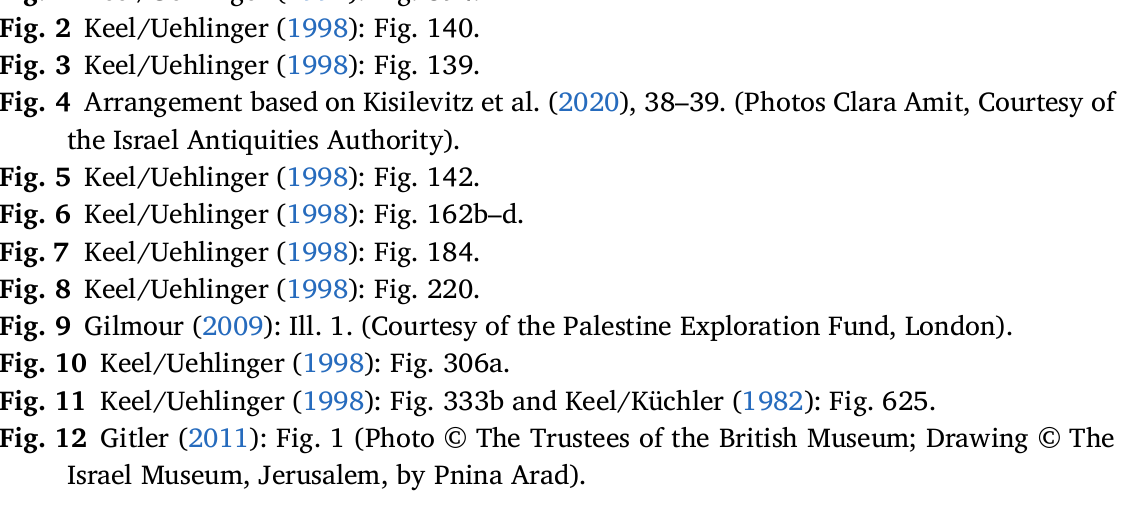
Fig. 1 Keel/Uehlinger (1992): Fig. 394. Fig. 2 Keel/Uehlinger (1998): Fig. 140. Fig. 3 Keel/Uehlinger (1998): Fig. 139. Fig. 4 Arrangement based on Kisilevitz et al. (2020), 38–39. (Photos Clara Amit, Courtesy of the Israel Antiquities Authority). Fig. 5 Keel/Uehlinger (1998): Fig. 142. Fig. 6 Keel/Uehlinger (1998): Fig. 162b–d. Fig. 7 Keel/Uehlinger (1998): Fig. 184. Fig. 8 Keel/Uehlinger (1998): Fig. 220. Fig. 9 Gilmour (2009): Ill. 1. (Courtesy of the Palestine Exploration Fund, London). Fig. 10 Keel/Uehlinger (1998): Fig. 306a. Fig. 11 Keel/Uehlinger (1998): Fig. 333b and Keel/Küchler (1982): Fig. 625. Fig. 12 Gitler (2011): Fig. 1 (Photo © The Trustees of the British Museum; Drawing © The Israel Museum, Jerusalem, by Pnina